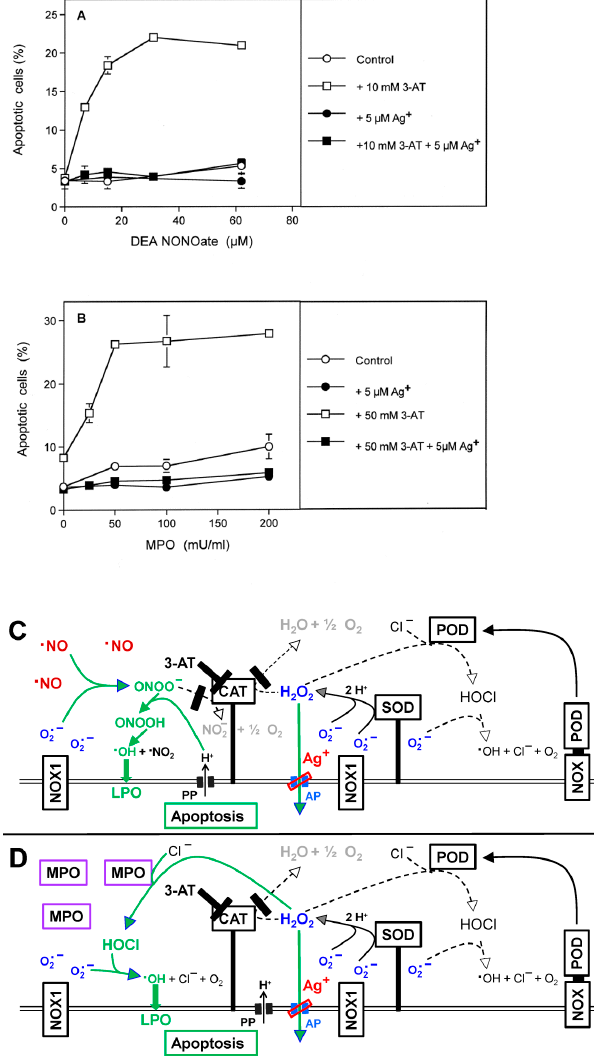
Figure 3. Aquaporin action is required for NO/peroxynitrite and HOCl signaling. MKN-45 gastric carcinoma cells were seeded at a density of 5000 cells ( A ) or 12 500 cells ( B ) in 96 well plates with 100 µL complete medium. Controls remained without 3-AT and Ag+, whereas the other assays received the indicated concentrations of 3-AT and/or Ag+. Assays under A received increasing concentrations of the NO donor DEA NONOate, whereas assays under B received increasing con- centrations of MPO. The percentages of apoptotic cells were determined after 2.5 h ( A ) or 1.5 h ( B ).